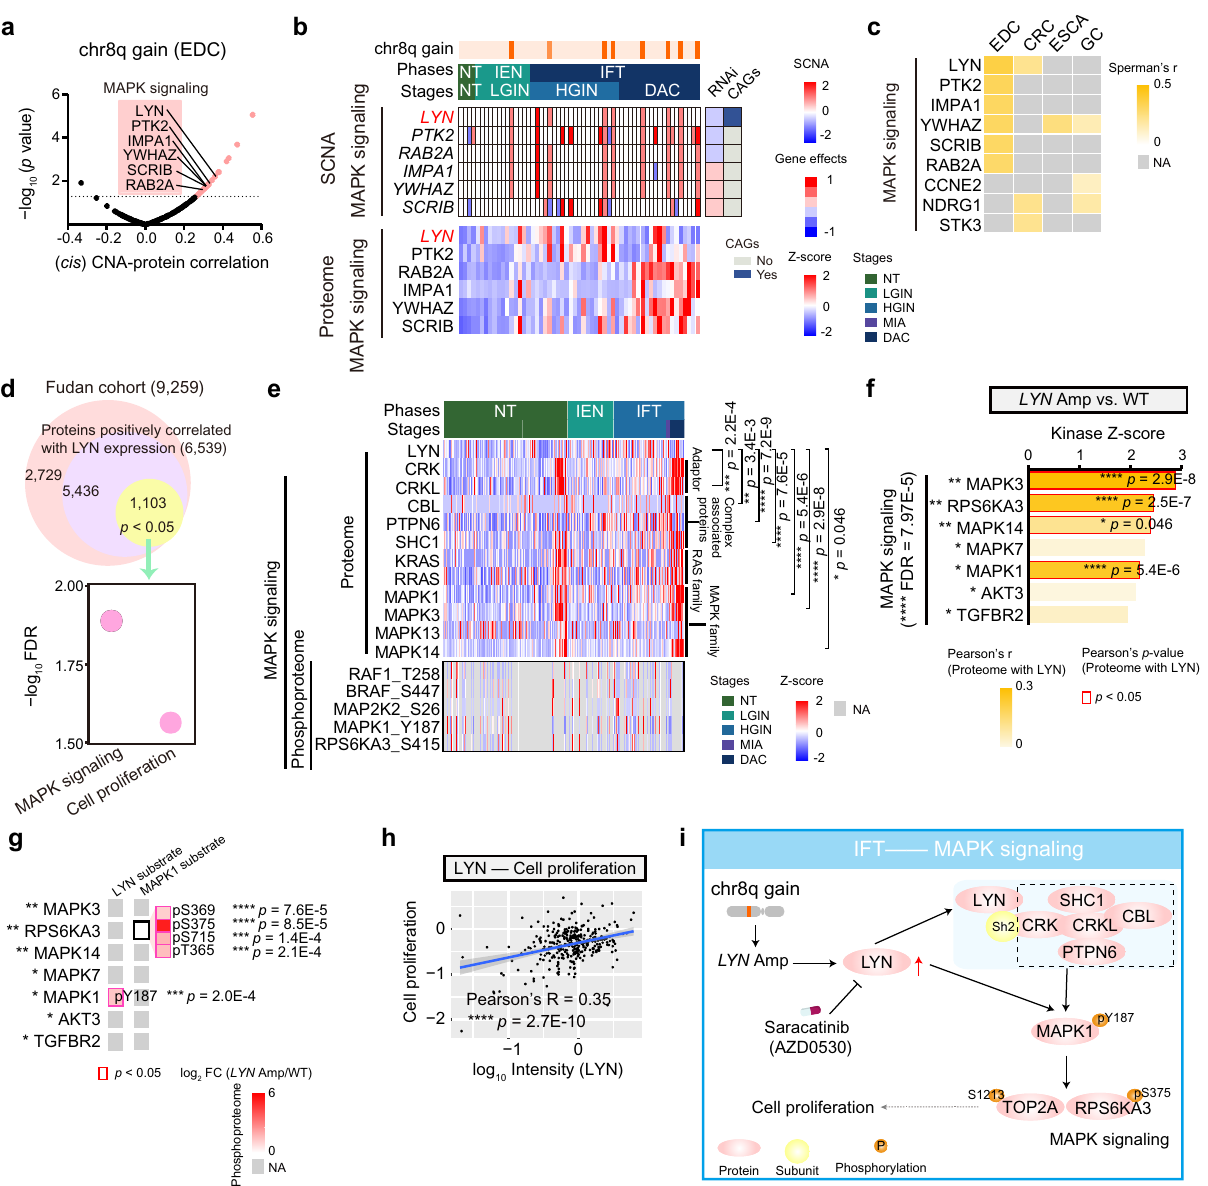
Fig. 3 | The impacts of chr8q gain in the D subtype. a Volcano plot showing the cis - correlation of the SCNA ( x -axis) and the associated − log 10 ( p -value) ( y -axis) on the genes at chr8q gain (two-sided Spearman ’ s correlation test). SCNA somatic copy number alterations. b The cis SCNA-protein regulations of signi fi cantly cor- related genes (top) on their corresponding proteins expression (bottom). The genesarerelatedtoMAPKsignaling.Therightrepresentsrelativesurvivalaveraged across all available DC cell lines after depletion of the indicated genes by RNAi (Dependency map-supported (https://depmap.org) panels) and shows the corre- lation between the genes and CAGs. CAGs cancer-associated genes. The square directstoasubsetofpatientsamplesintheDsubtypeusedforWES( n =120). c The impacts of the MAPK signaling associated SCNAs on their corresponding protein expression in gastrointestinal cancers (two-sided Spearman ’ s correlation test). d Venn diagram depicting the ampli fi cation of LYN positive associated proteins (top), and the represented signaling pathways (bottom). e Heatmap showing the